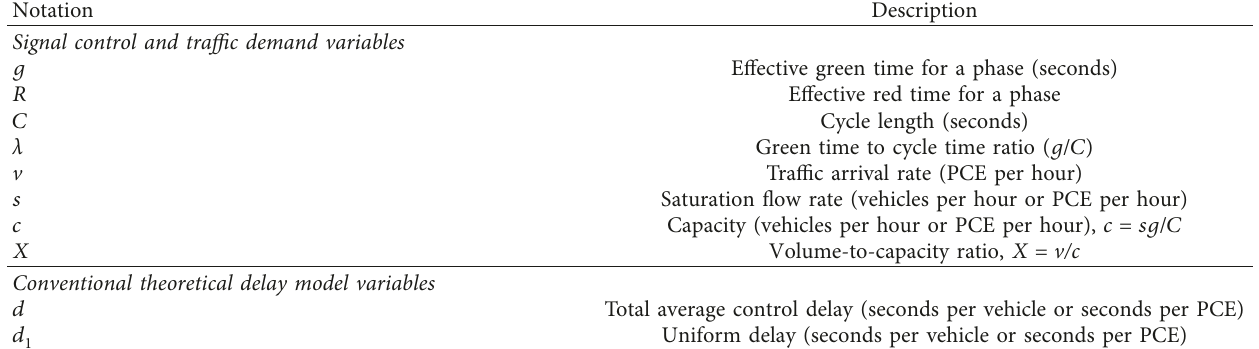
Table 1: List of